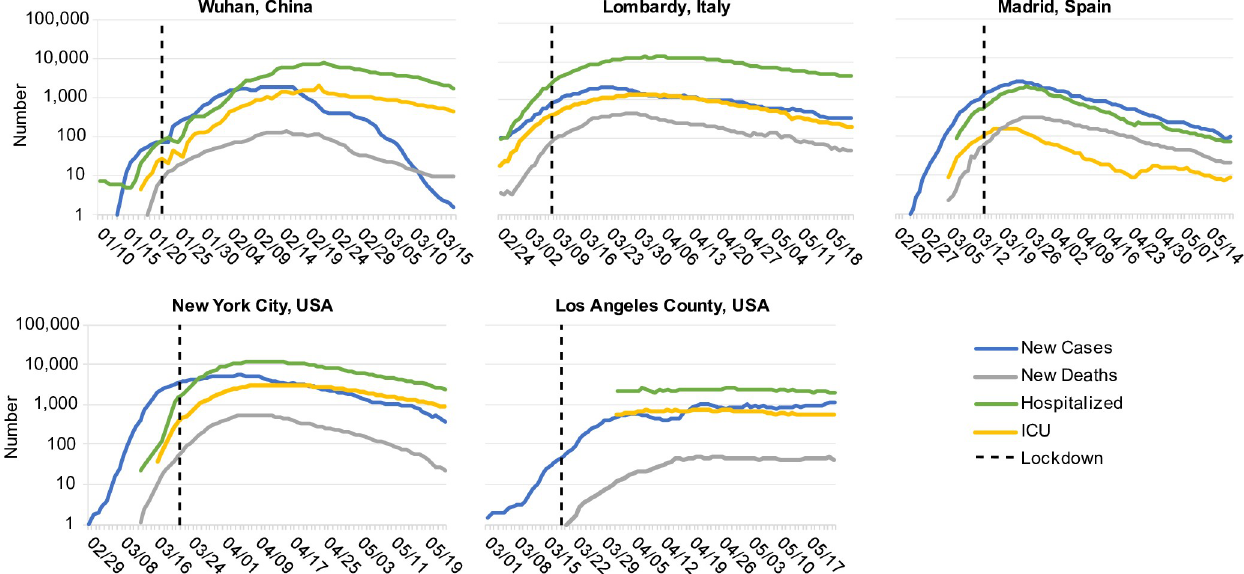
Fig 1. COVID-19 dynamics before and after lockdown interventions in five example regions. A) The city of Wuhan, China (8.5K km 2 , 11.1M ppl), B) The Lombardy region of Italy (23.8K km 2 , 10.1M ppl) C) The autonomous Community of Madrid in Spain (8.0K km 2 , 6.6M ppl) D) New York City in the state of New York, USA (1.2K km 2 , 8.2M ppl). E) The county of Los Angeles, California, USA (4.7K km 2 , 9.8M ppl). “New cases” and “New deaths” are daily numbers of new reports, averaged over a 7 day window centered on the current day. For Lombardy, New York, and Los Angeles, “Hospitalized” and “ICU” are the total number of patients currently in regular hospital care or critical care, respectively. In Wuhan, the same time series are the number of patients currently categorized as having “severe” or “critical” infection (using the same definitions as in our model). In Madrid, due to data availability, these series are instead the daily number of new admissions (with 7-day